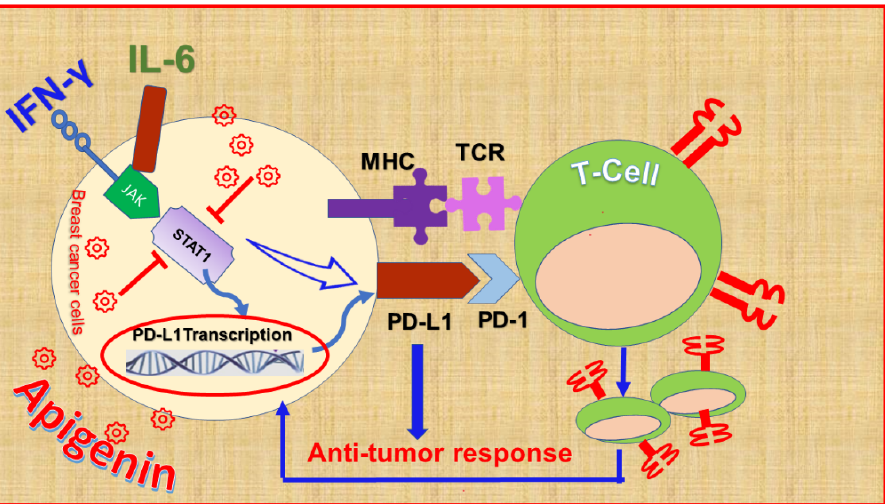
Figure 4. The mechanisms of Apigenin-mediated programmed death-ligand 1 (PD-L1) inhibition in breast cancer cells. Interferon-gamma, IFN- γ ; Interleukin 6, IL-6; Janus kinase, JAK; signal transducer and activator of transcription1, STAT1; major histocompatibility complex, MHC; T-cell receptor, TCR; programmed cell death protein 1,